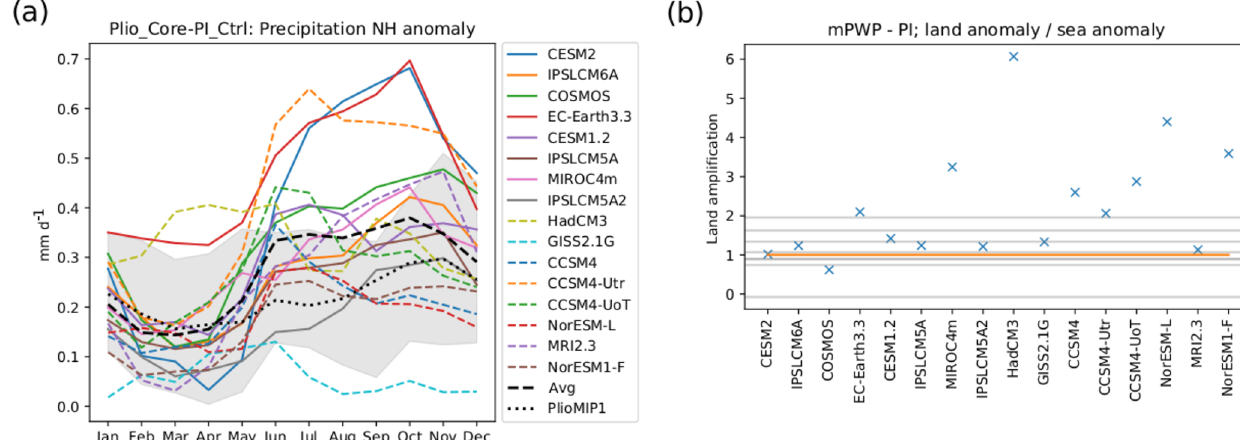
Figure 6. (a) The NH averaged precipitation anomaly for each PlioMIP2 model and for each month with the dashed black line showing the PlioMIP2 multi-model mean. The grey shaded region shows the range of values obtained from PlioMIP1 with the PlioMIP1 multi-model mean shown by the dotted black line. (b) The ratio of the precipitation anomaly over land to the precipitation anomaly over sea for each PlioMIP2 model. Analogous results from individual PlioMIP1 models are shown by the thin grey lines. A ratio of 1.0, where the land precipitation anomaly is the same as the sea precipitation anomaly, is shown in